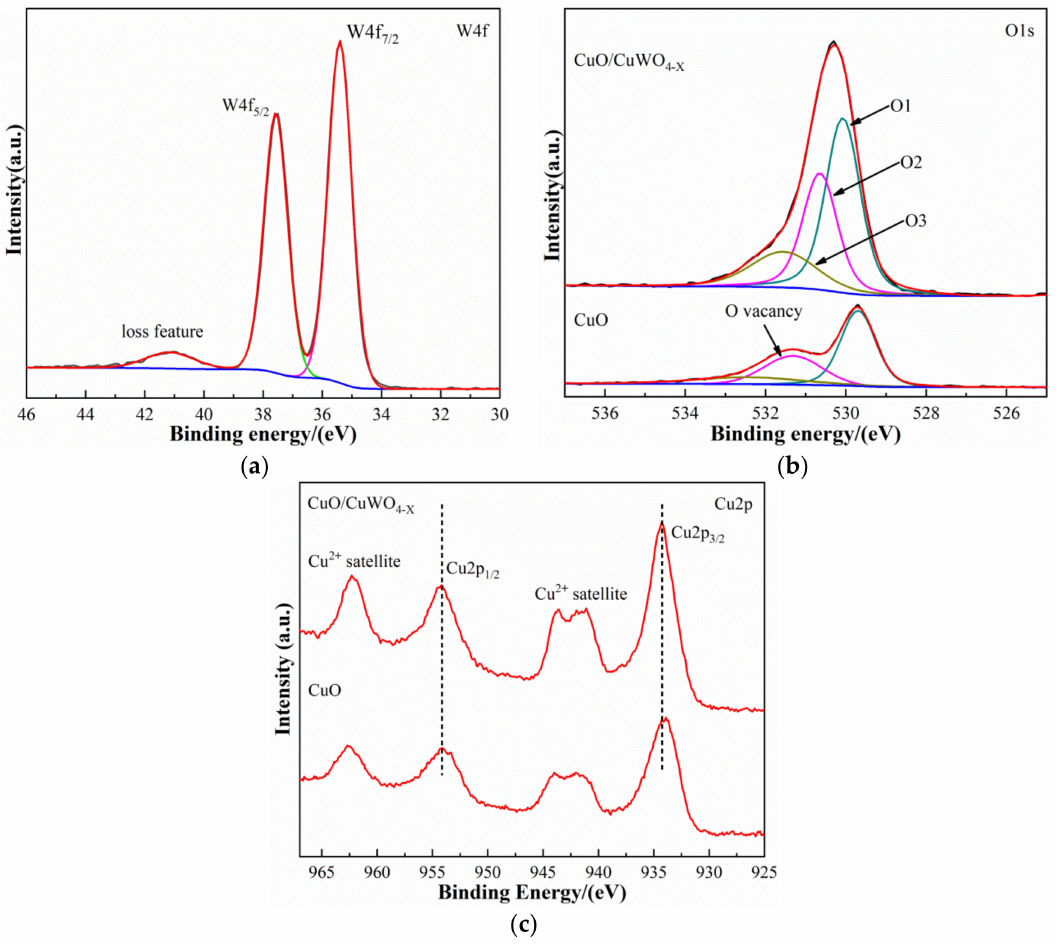
Figure 8. XPS spectra of pure Cu and Cu-20 wt%W precursor powders calcined at 500 ◦ C for 2 h: ( a ) W4f; ( b ) O1s; ( c )